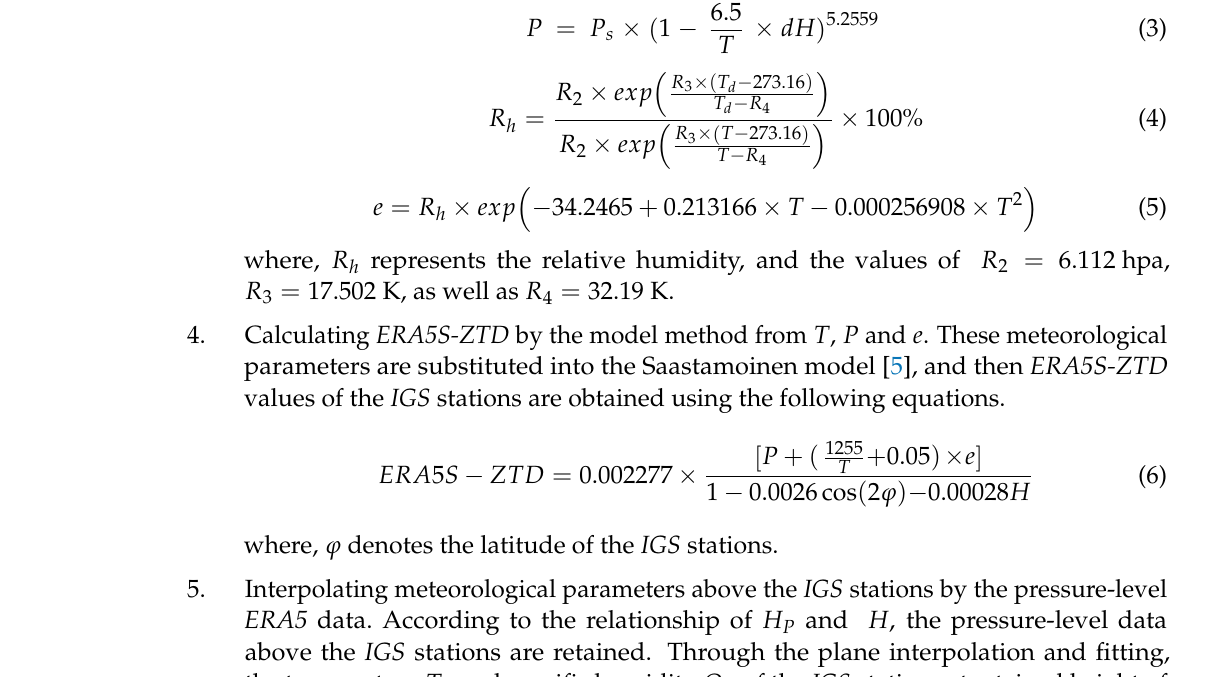
Interpolating meteorological parameters above the IGS stations by the pressure-level ERA5 data. According to the relationship of H P and H , the pressure-level data above the IGS stations are retained. Through the plane interpolation and fitting, the temperature T P and specific humidity Q P of the IGS stations at retained height of H P are derived. The water vapor pressure e P is obtained through Q P and P P .